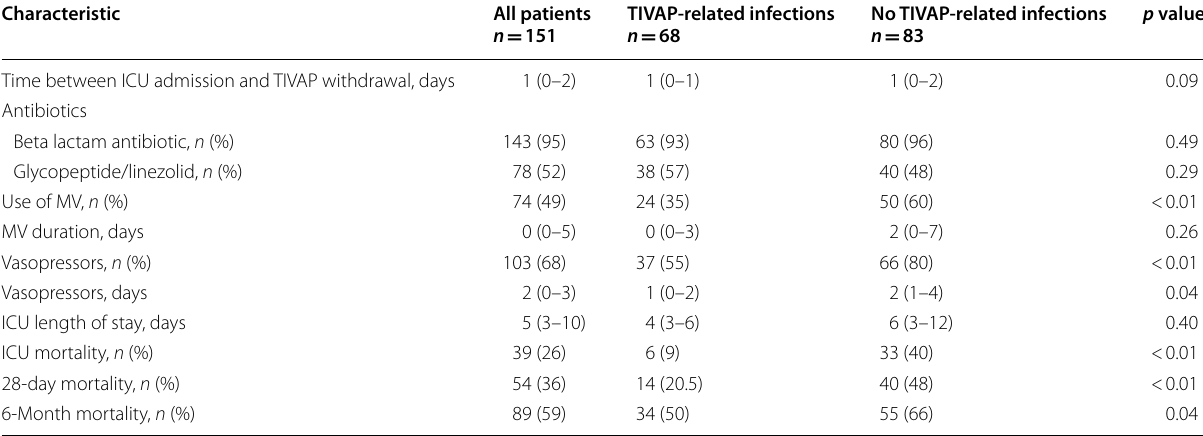
Table 4 Therapeutic management and outcome of patients with and without TIVAP (totally implanted venous access port)-related infection